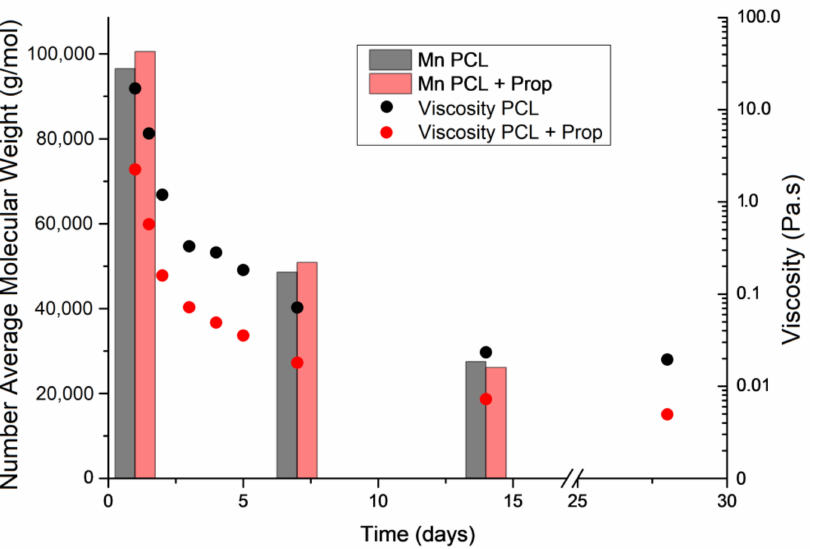
Figure 2. Number average molecular weight and viscosity for PCL and PCL + Prop solutions after days of